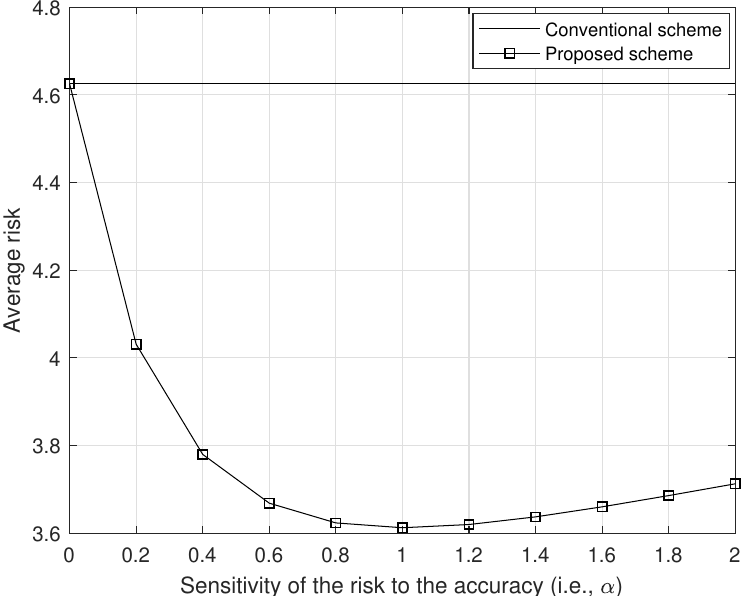
Figure 9. The average risk with respect to the sensitivity of the risk to the position accuracy (i.e., α